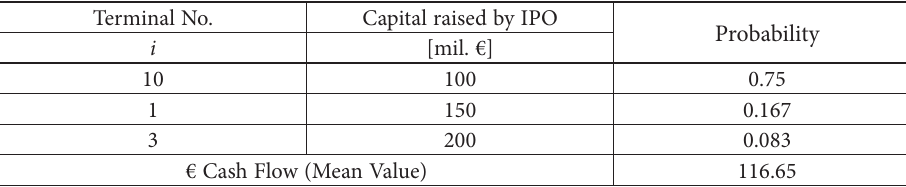
Table 8. Probabilities of the capital raised by IPO and the mean value